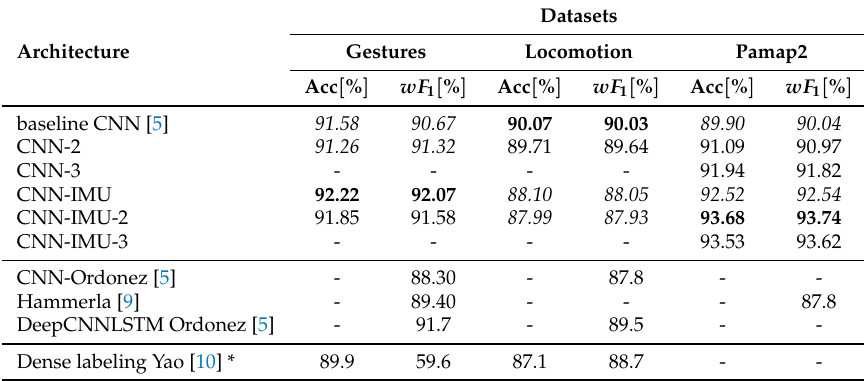
Table 14. Comparison between the testing accuracies and Weighted F1 for the best performances using CNNs and state-of-the-art on the Opportunity and Pamap2 datasets. Results marked with ‘*’ cannot be directly compared, as the authors in [10] predict action classes per sample and they do not follow a sliding window-approach.